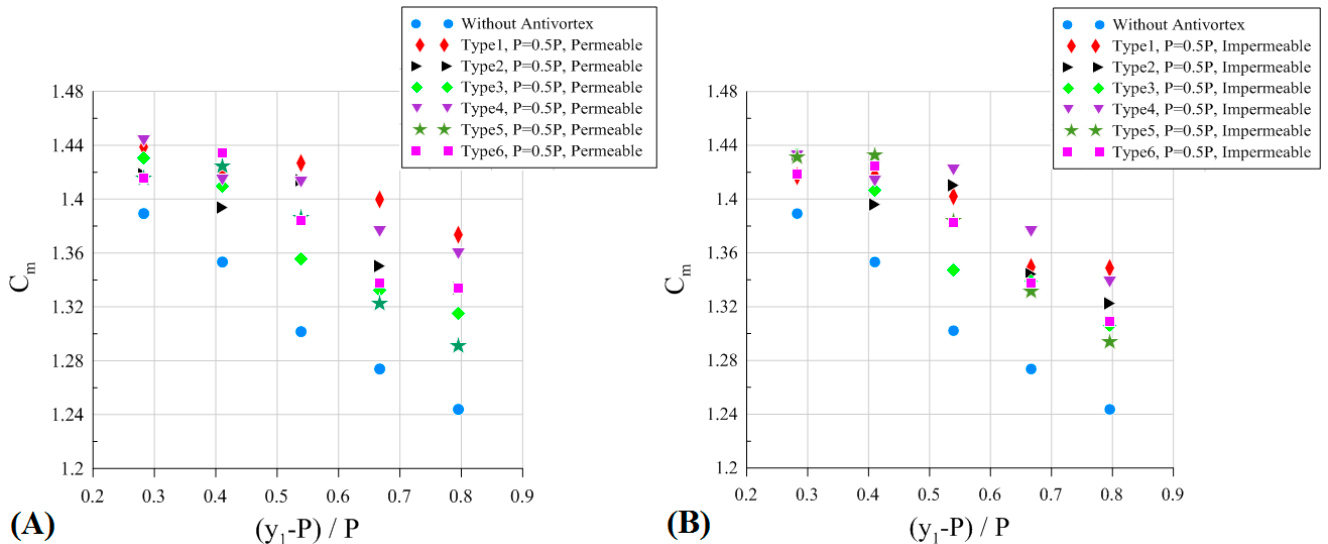
Figure 19. Variations in C m with (y 1 − P)/P in triangular labyrinth side weirs. ( A ): Permeable antivortex; ( B ): Impermeable antivortex.